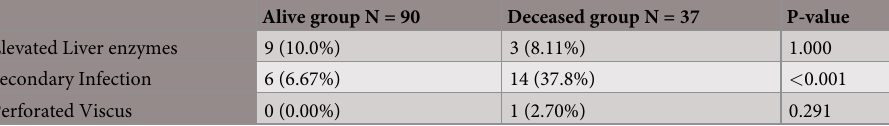
Table 3. Prevalence of adverse events post tocilizumab